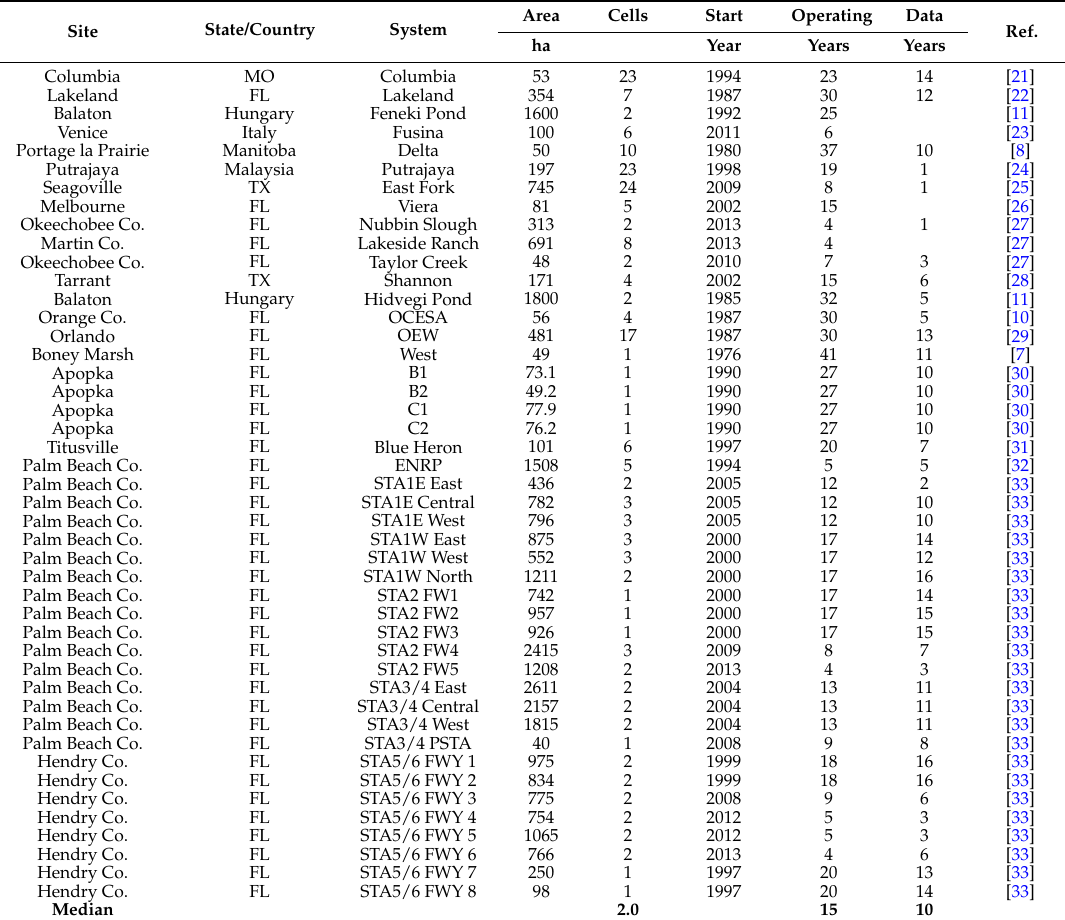
Table 1. Large constructed wetlands treating phosphorus. Columbia and Lakeland do not specifically target